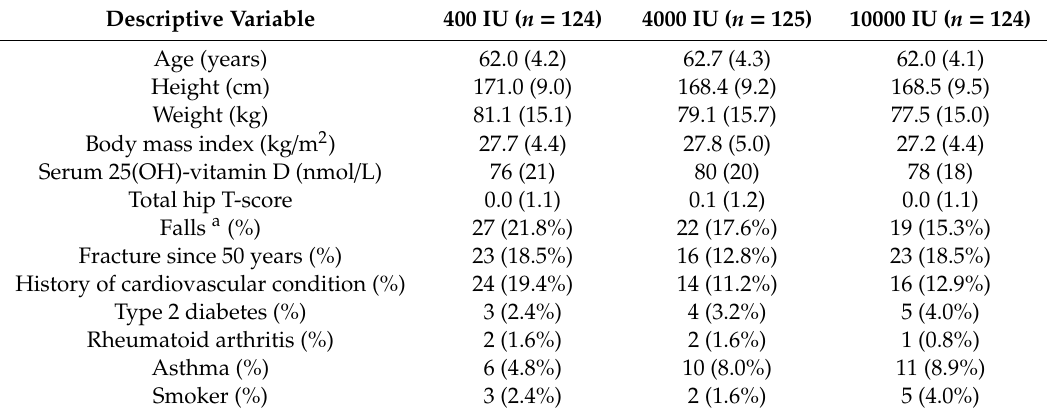
Table 1. Participant characteristics at